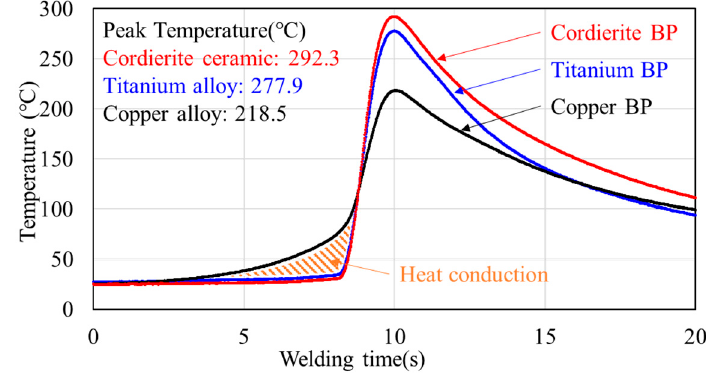
Figure 3. Welding temperature at the bottom of the welding line.